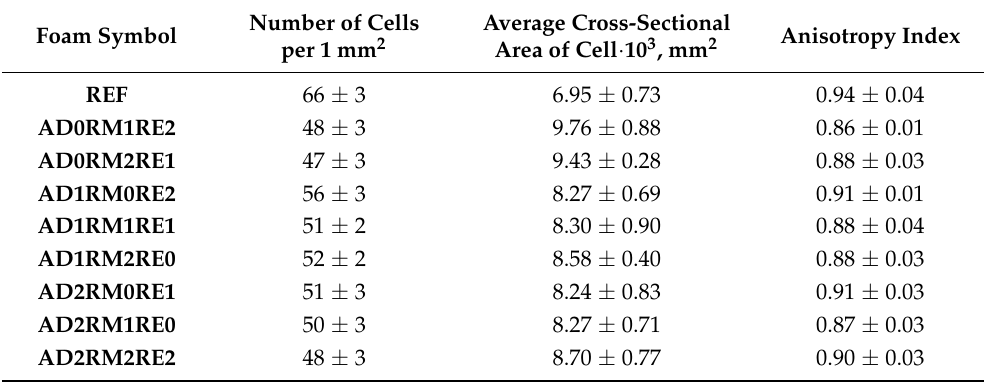
Table 2. Parameters of the cell structure of rigid polyurethane foams in the cross-section perpendicular to the foam rise